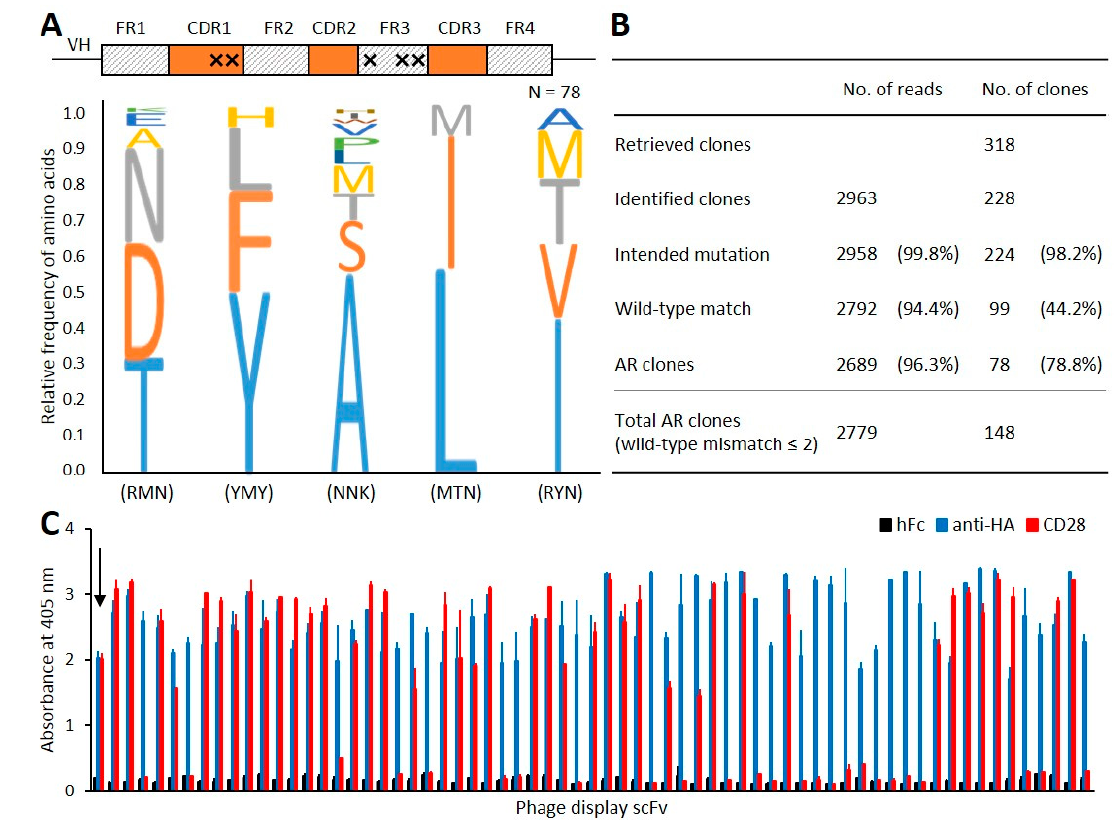
Figure 4. Binder identification from the phage fluorescence microwell immunoassay of a mutagenesis deimmunization library. ( A ) Mutation frequency patterns in the five randomization residues. Two residues in HCDR1 and three residues in HFR3 were randomized from the wild-type clone. ( B ) Analysis of high-throughput sequencing data for the identification of scFv clones as well as valid mutations. ( C ) Representative monoclonal phage ELISA result. The arrow indicates a wild-type clone. Each bar represents the absorbance value against hFc fusion protein (negative control, black), anti-HA antibody (positive control, blue), and CD28 fusion protein (target, red), respectively.